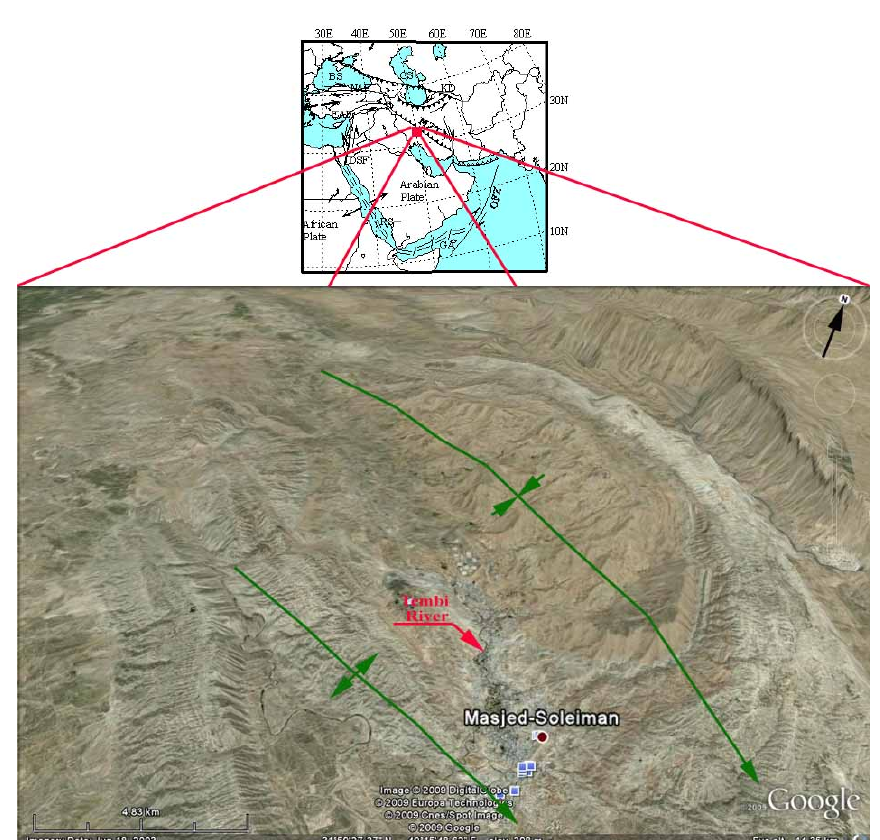
Figure 1. Geographical location of Masjed-i-Soleiman area (Google earth 2009 with